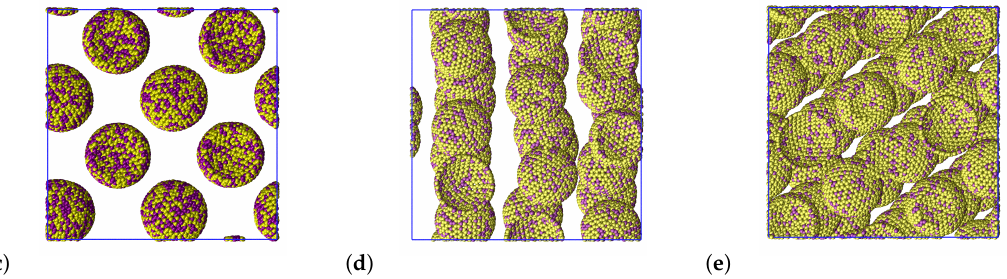
Figure 4. NP center–NP center radial distribution functions for dispersed p3-charged systems with a degree of polymerization ( a ) N = 100 and ( b ) N = 200. The bottom row shows the corresponding top-view snapshots of N = 100 systems at the NP volume fractions of ( c ) φ = 20.8%, ( d ) φ = 28.2%, and ( e ) φ = 37.2%. Only the NPs are shown here for the sake of clarity. Yellow and purple spheres stand for the neutral and charged surface beads respectively. 3D views of the systems shown in ( c – e ) are available in Supplementary Figure